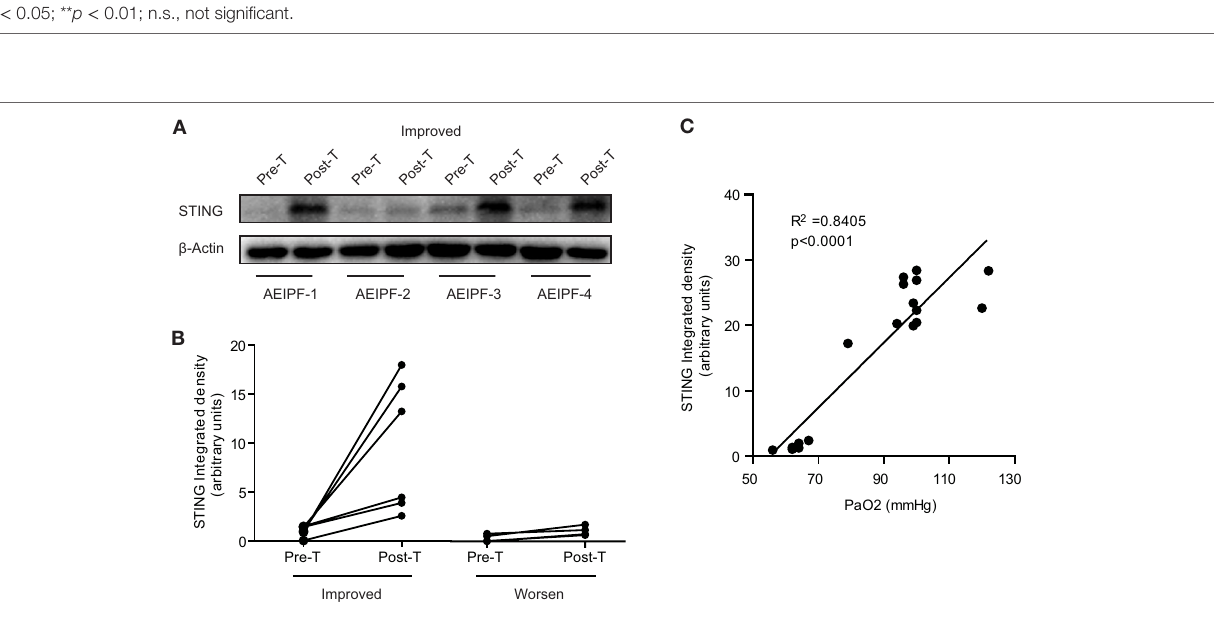
FigUre 7 | Stimulator of interferon genes (STING) protein levels in peripheral blood mononuclear cells (PBMCs) reflected the prognosis of acute exacerbation of idiopathic pulmonary fibrosis (AE-IPF). (a) Representative western blot image of STING protein expression in PBMCs isolated from 10 patients with AE-IPF (6 cases of improvement + 4 cases of deterioration) before and after the treatment. (B) Quantification of the Western blot in panel (a) . Six patients with improvement showed increased STING expression in PBMCs after treatment. Four patients with deterioration showed unchanged STING expression after treatment. (c) STING protein expression levels positively and significantly correlated with pre-treatment PaO 2 levels. Six cases were randomly selected from healthy control, stable IPF, and AE-IPF groups, respectively. Abbreviations: pre-T, pre-treatment; post-T, post-treatment.